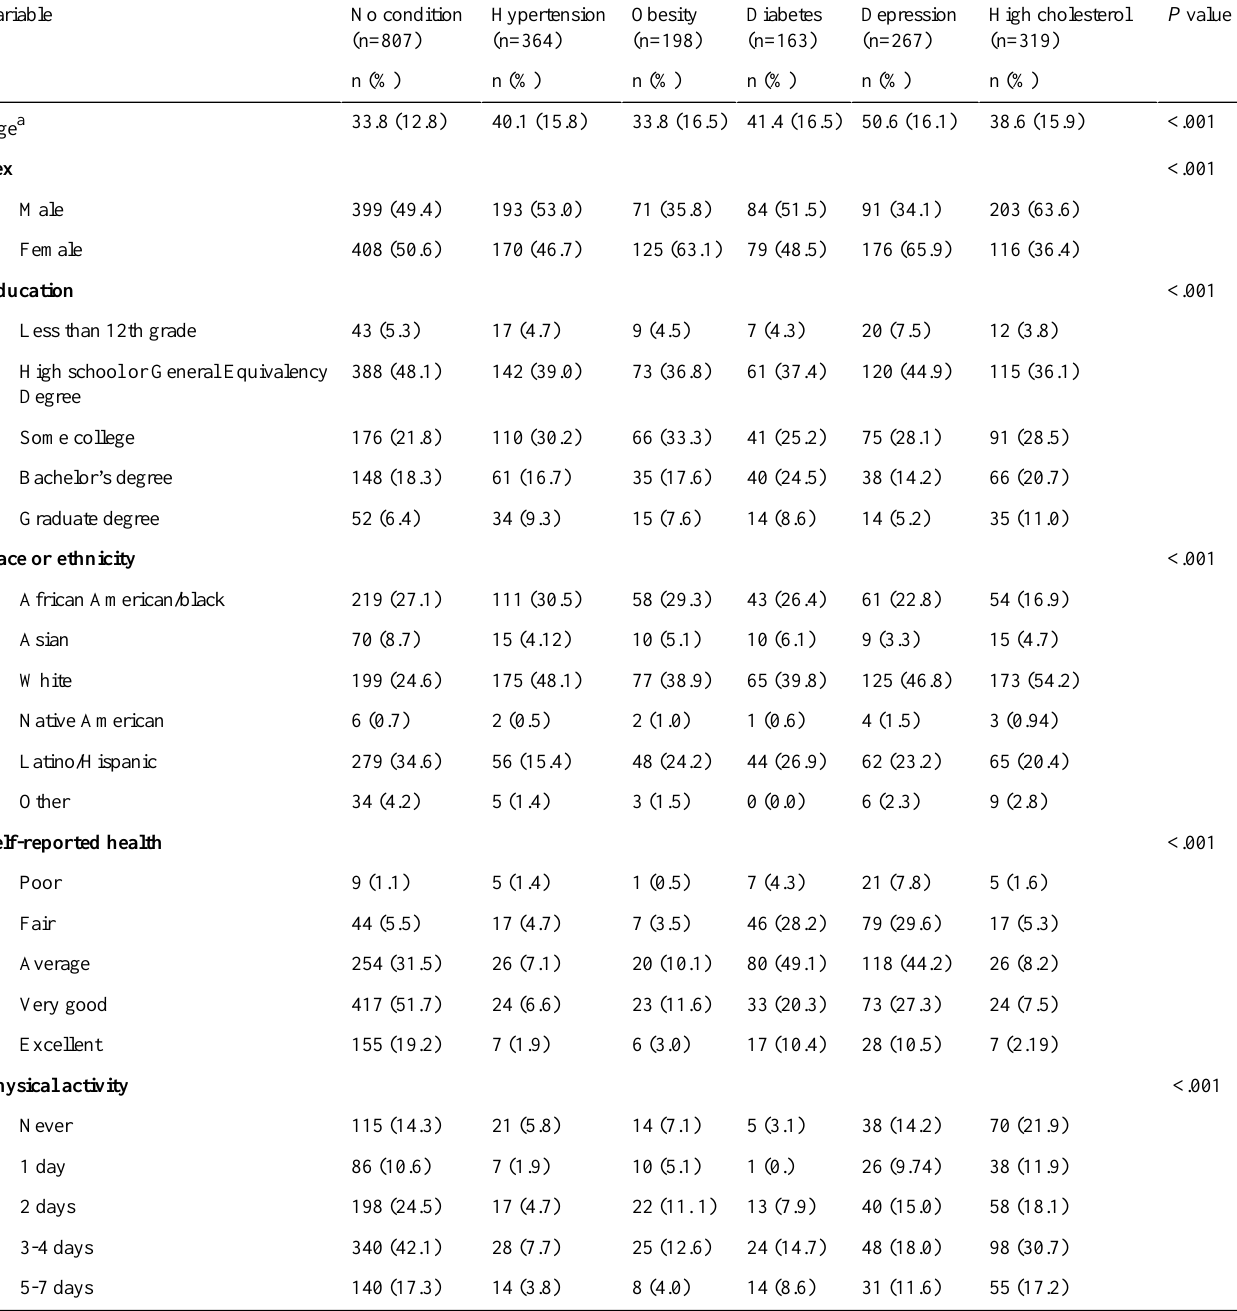
Table 1. Demographic characteristics of mobile phone users in the United States by chronic condition